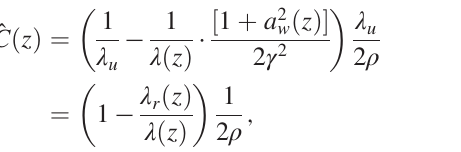
¼ 4 (blue lines) along the planar undulator UT